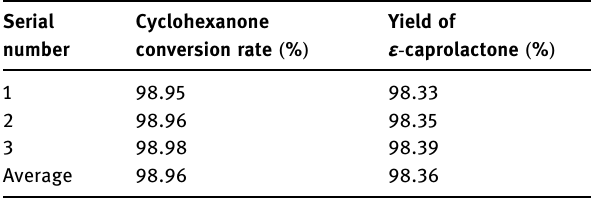
Table 2: Investigation of the reaction stability